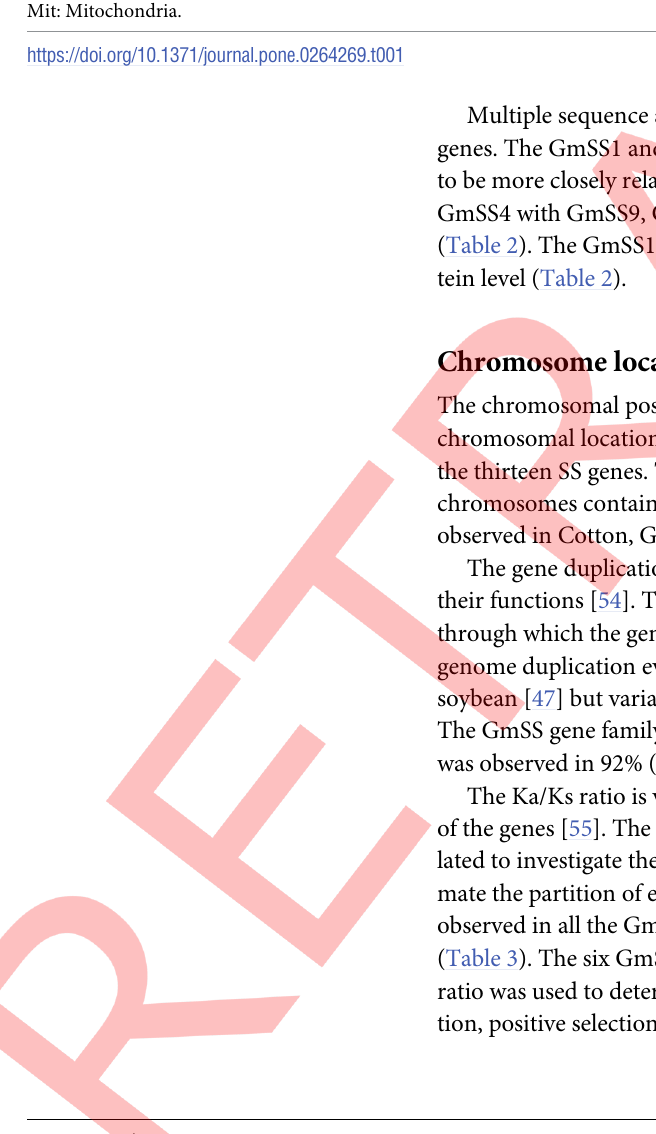
The genes were arranged according to their placement in different classes. Cyto: